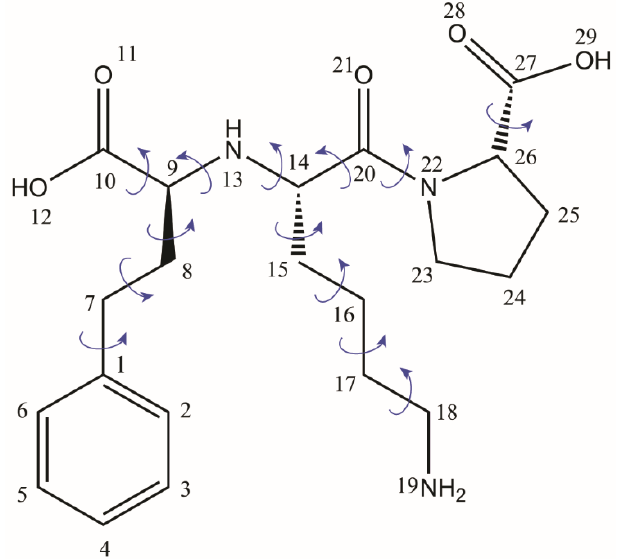
Figure 2. The chemical structure of Lisinopril, which emphasizes the flexible torsion angles considered for powder X-ray diffraction (PXRD) structure determination.